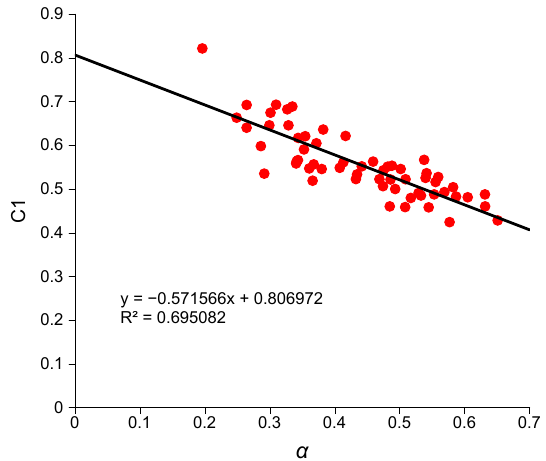
Fig. 5. Relationship between C1 and α for all sections of each snow- fall time